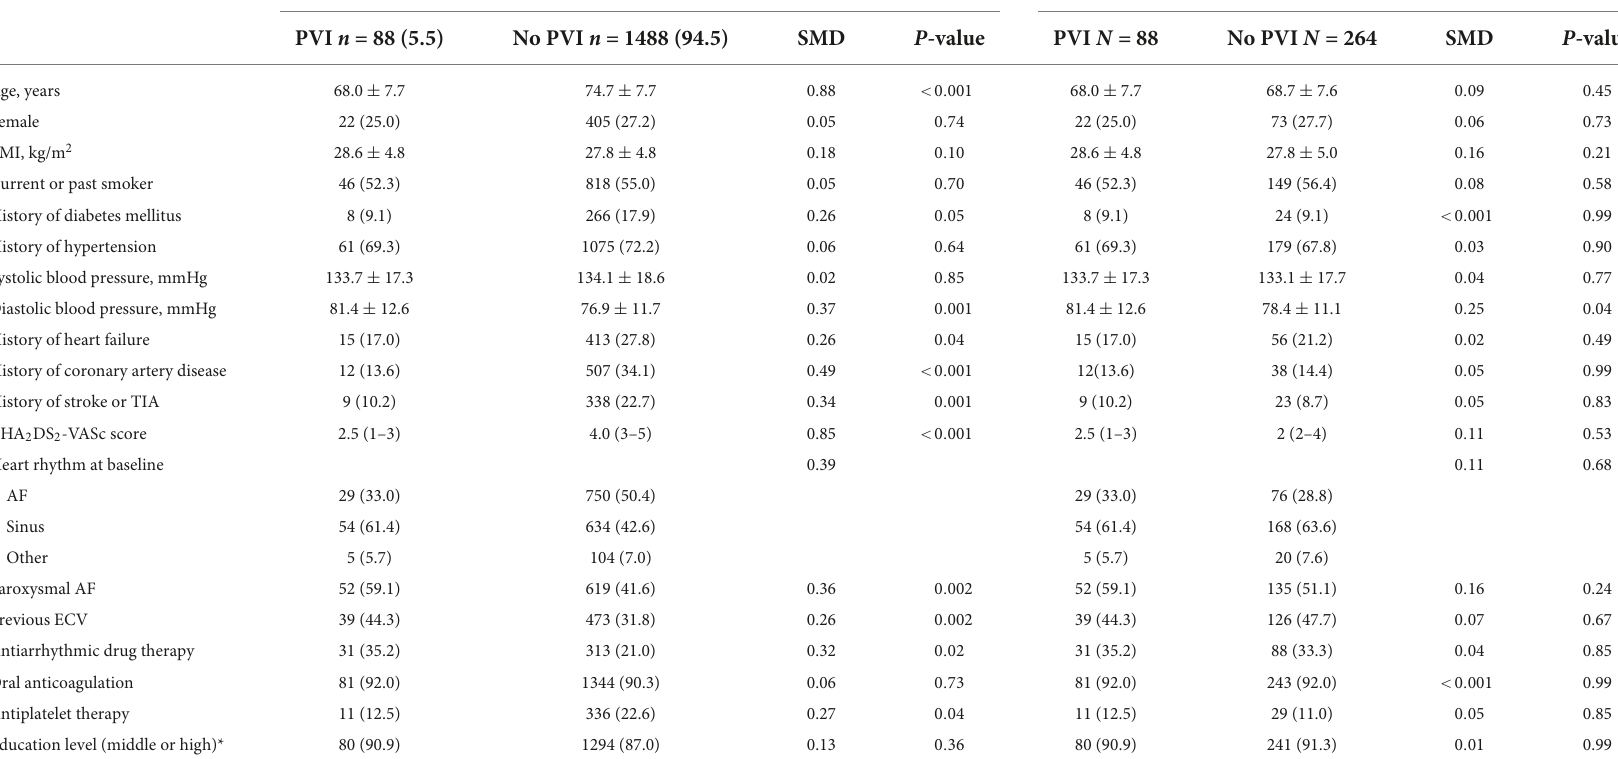
TABLE 1 Baseline characteristics of the overall and propensity-score matched population. Overall population Propensity score matched population